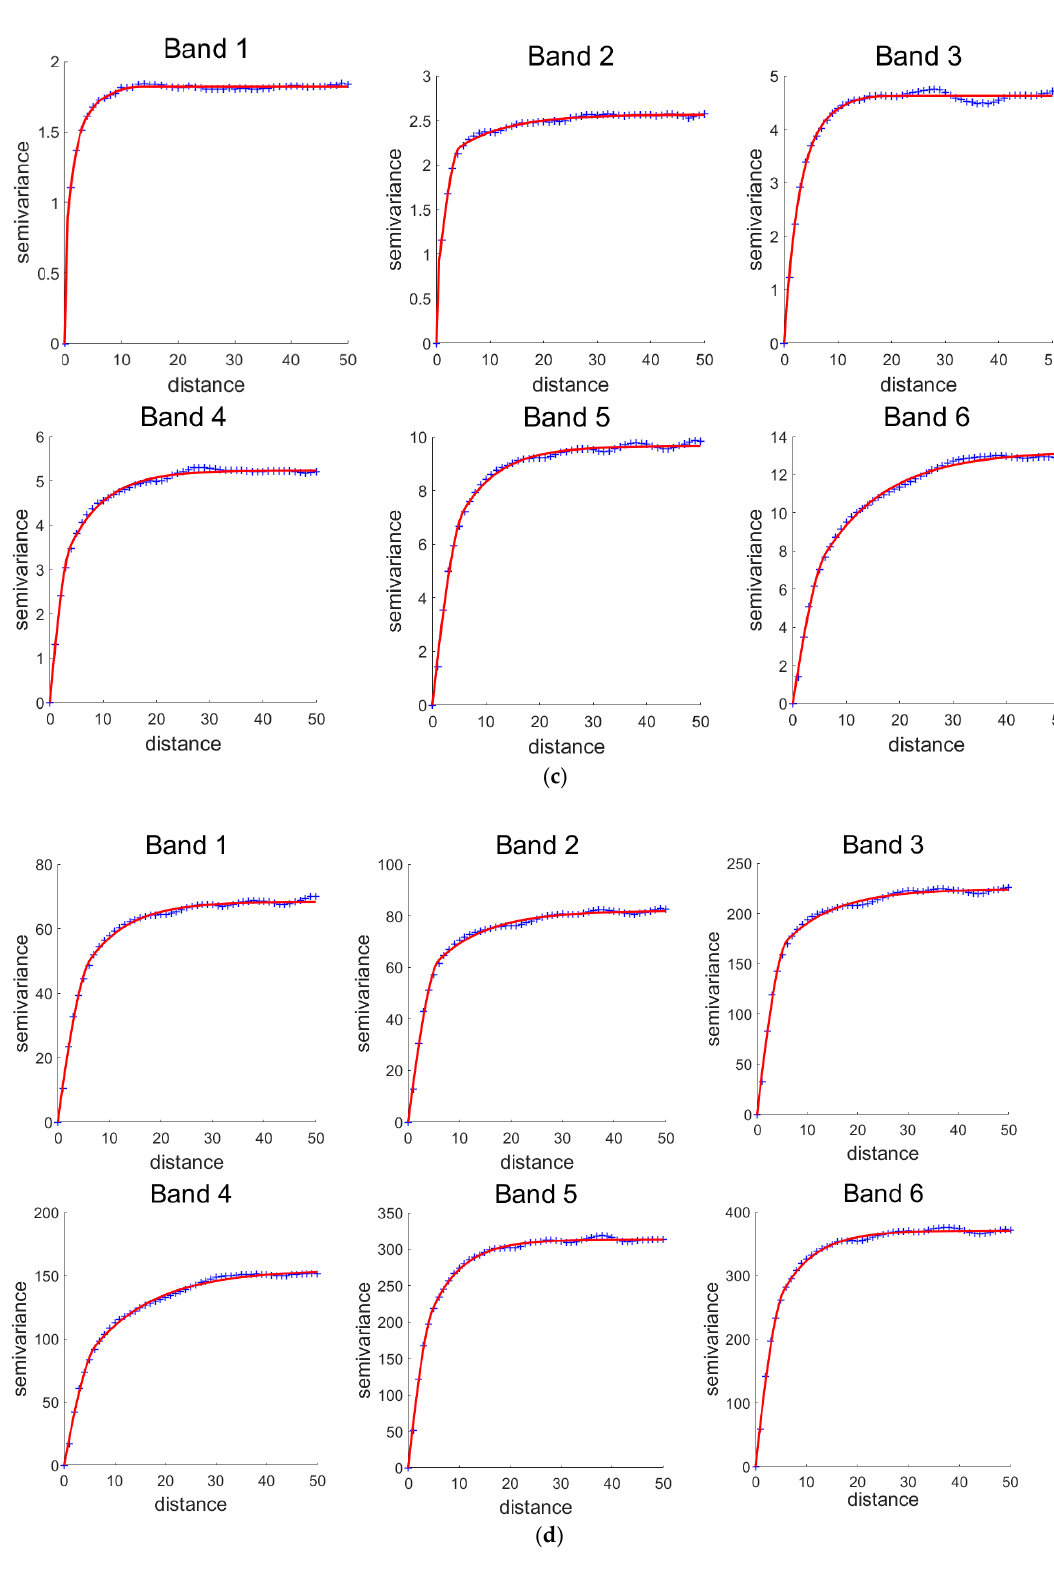
Figure A2. The experimental variograms (blue cross) and the corresponding models fitted (red lines) for the agricultural image subset: ( a ) ICA- and normal-transformed image bands ( Z (cid:48)(cid:48) ( b ) ICA-transformed image bands ( Z (cid:48) ( d ) original image bands ( Z